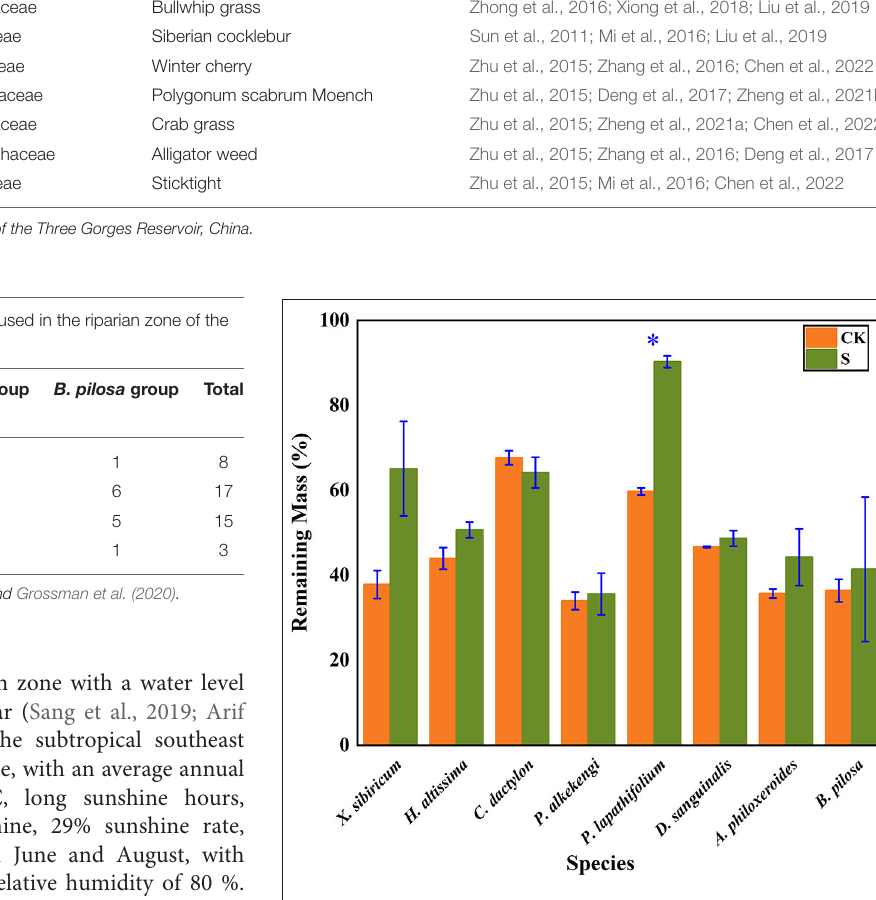
FIGURE 1 | Bar charts show individual species’ mass remaining litter rates within the hydro-fluctuation zone (S) and the terrestrial zone (CK). The y-axis shows the mean value (%). The vertical whisker represents the standard deviation. Paired tests were used to determine the differences between S and CK. * Indicates significant differences at P <